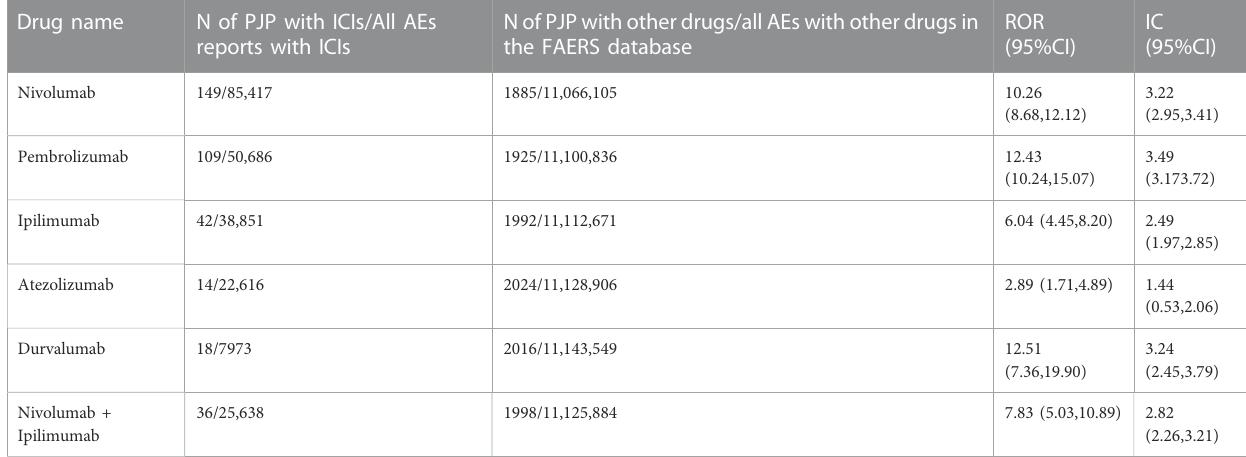
TABLE 2 Pneumocystis jirovecii pneumonia signals of different immune checkpoint inhibitors after sensitivity analysis. Drug